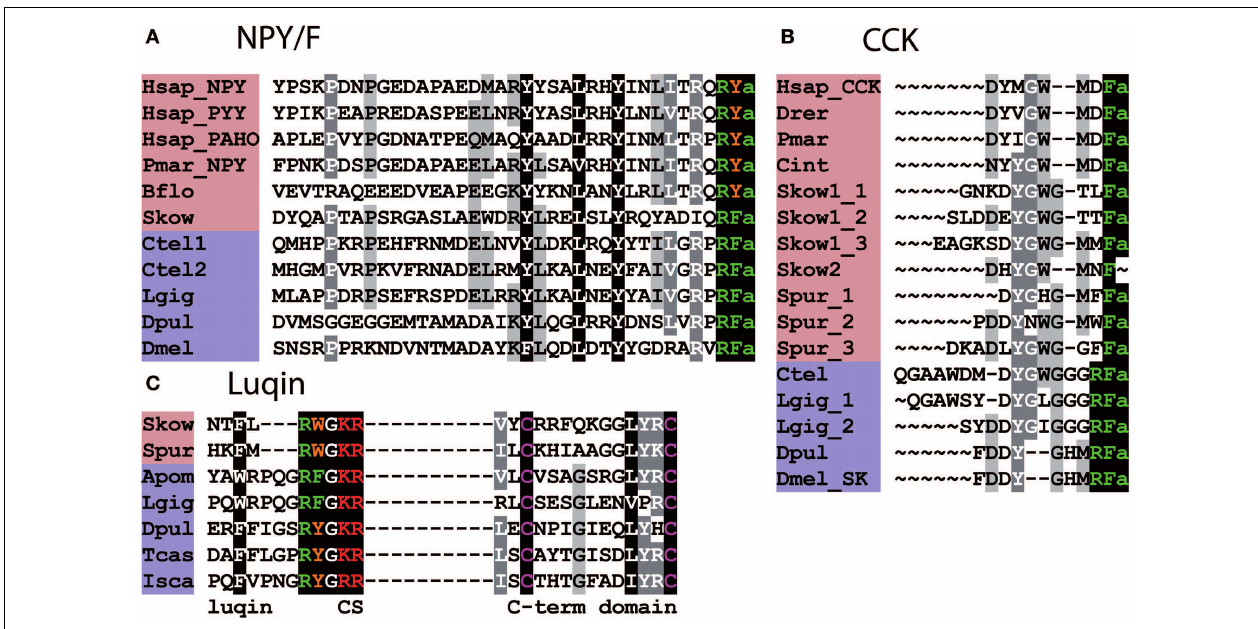
FIGURE 3 |Alignment of known orthologous peptides from (A) bilaterian NPY/NPF, (B) bilaterian Cholecystokinin/Gastrin (CCK), and (C) bilaterian Luqin/RYamide families .The names of deuterostomian and protostomian peptides are shaded in pink and blue, respectively.The C-terminal amide groups are represented by an “a” at the end of aligned sequences. Skow Luqin is from Ref. (7), Spur Luqin is from Ref. (75), andTcas Luqin/RYamide is from Ref. (76).The Lottia gigantea sequences are from Ref. (4), the Capitella teleta sequences are from Ref. (5), and other sequences are from Ref. (8). For vertebrate sequences, only one peptide from each precursor is shown in the alignment. Genbank (GI) or JGI IDs of all precursor sequences are listed below: (A) Alignment of bilaterian NPY/F-type peptides: Hsap_NPY, Hsap_PYY, and Hsap_PAHO; Homo sapiens NeuropeptideY,